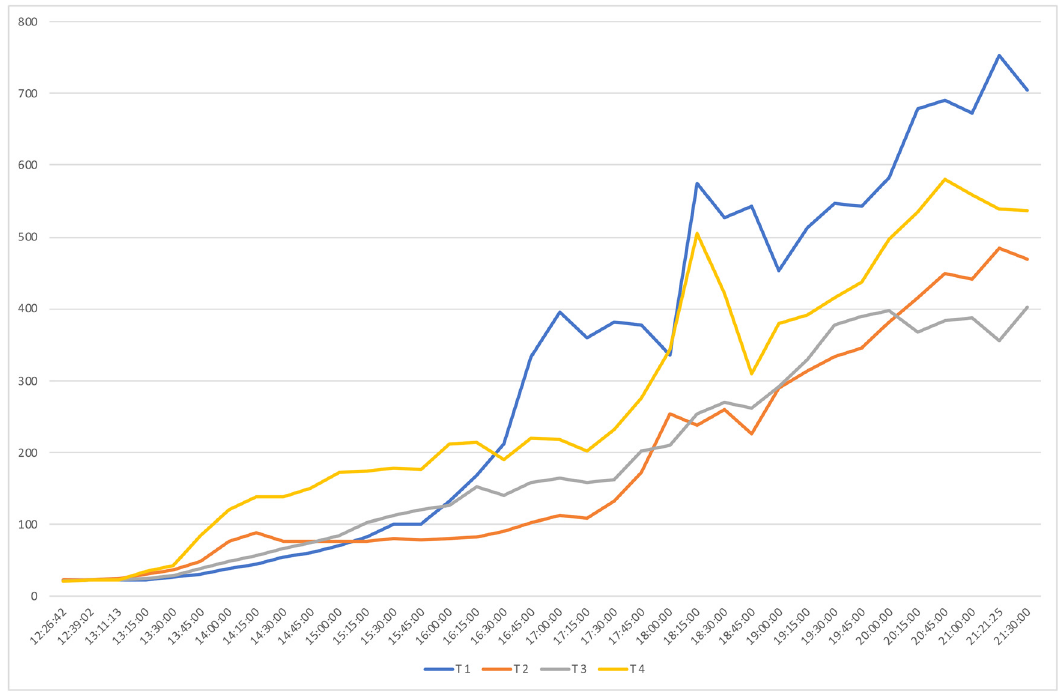
Figure 9: Temperature trend recorded in pottery fi ring experiment